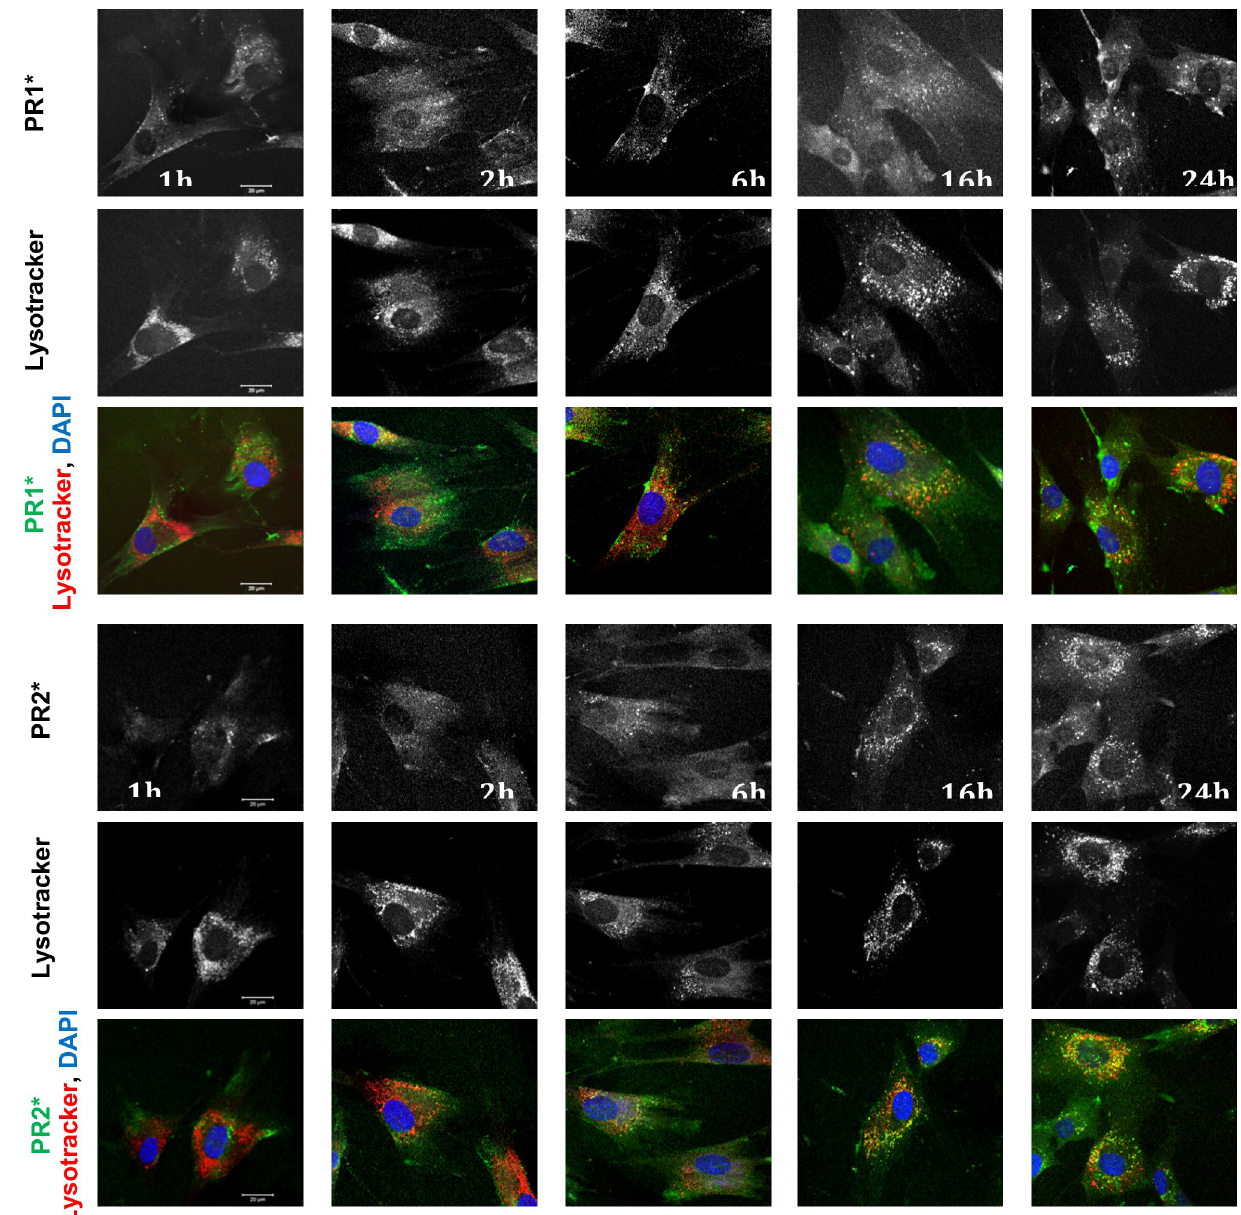
Fig 3. Time course of FITC-conjugated PRs (PR1 � and PR2 � ) localization in NPC1-deficient fibroblasts. Cells were incubated with the compounds for the indicated times (h) and then washed and stained with lysotracker for an additional 45 min. The cells were fixed with paraformaldehyde, followed by staining of nuclei by DAPI. Cells were imaged by confocal microscopy as described in Methods.